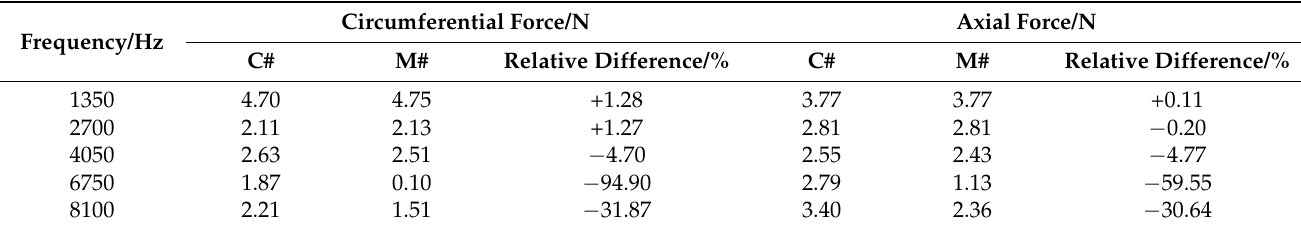
Table 2. Main frequency component of R1 rotor blade